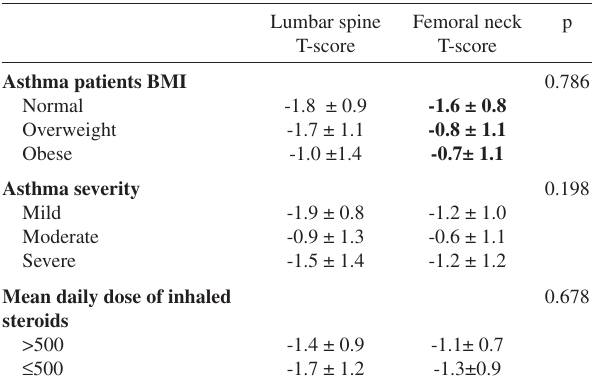
Table 4 - Relationship between asthma severity, ICS and